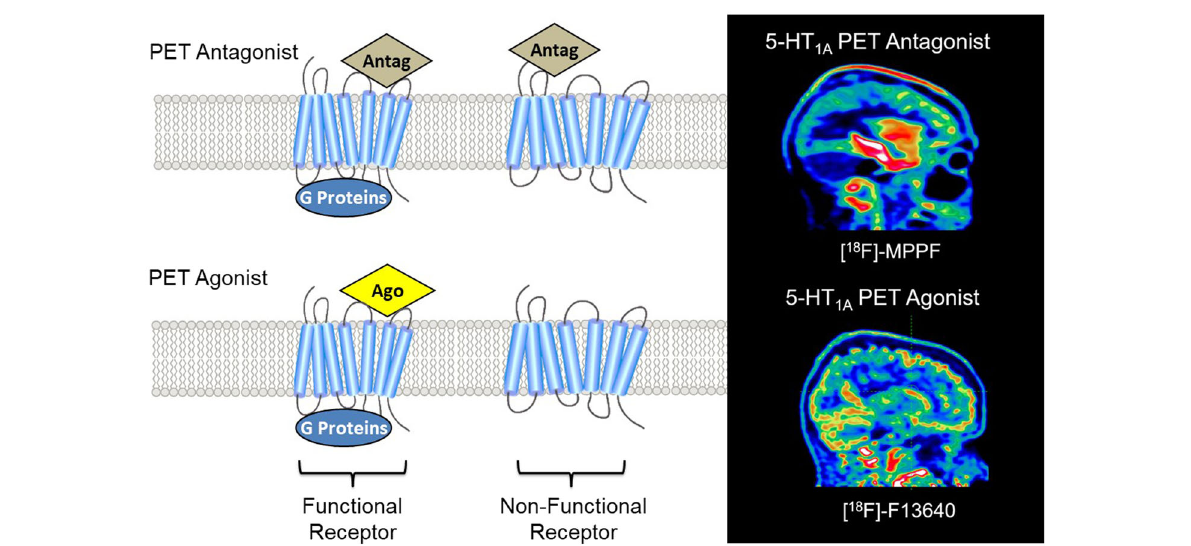
Fig. 1 Comparison of PET antagonist and agonist radiotracer binding. The antagonist radiotracer binds to all states of the receptors, i.e. functional (bound to G protein) and non-functional (uncoupled form) whereas the agonist only binds to functional receptors (bound to G protein). As a result, the binding pattern at 5-HT 1A receptors differs signi fi cantly between the antagonist [ 18 F]-MPPF (binding in hippocampus, cingulate cortex and raphe nuclei) and the agonist [ 18 F]-F13640 (binding mainly in cortical and cerebellar